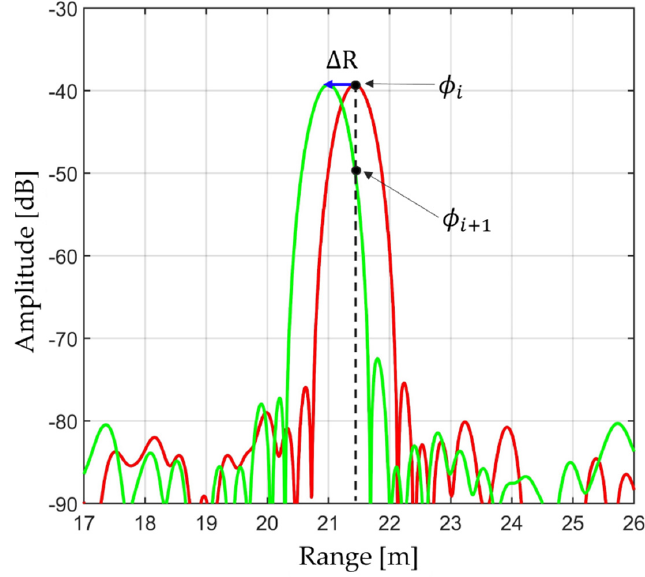
Figure 3. Interferometric method for GPR positioning.